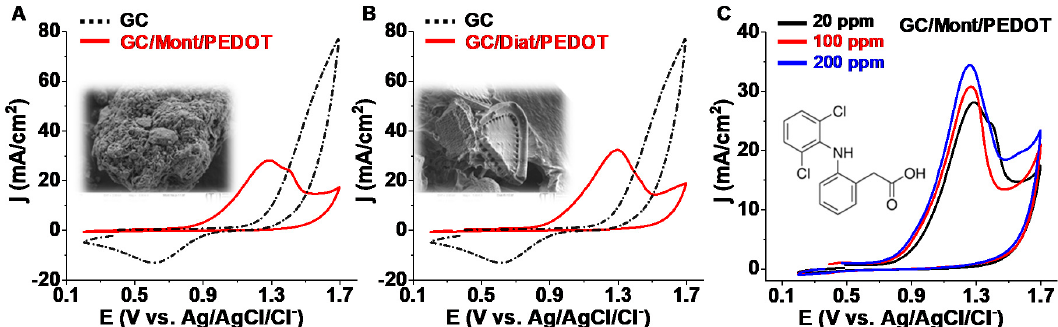
Figure 8. Voltammetric response (first scans) of the GC/Mont/PEDOT ( A ) and GC/Diat/PEDOT ( B ) hybrid materials in the presence of diclofenac (20 ppm sodium diclofenac). ( C ) Effect of diclofenac concentration (20–200 ppm) for GC/Mont/PEDOT (example). In all cases, the supporting electrolyte was 0.5 M H 2 SO 4 and v = 50 mV/s.